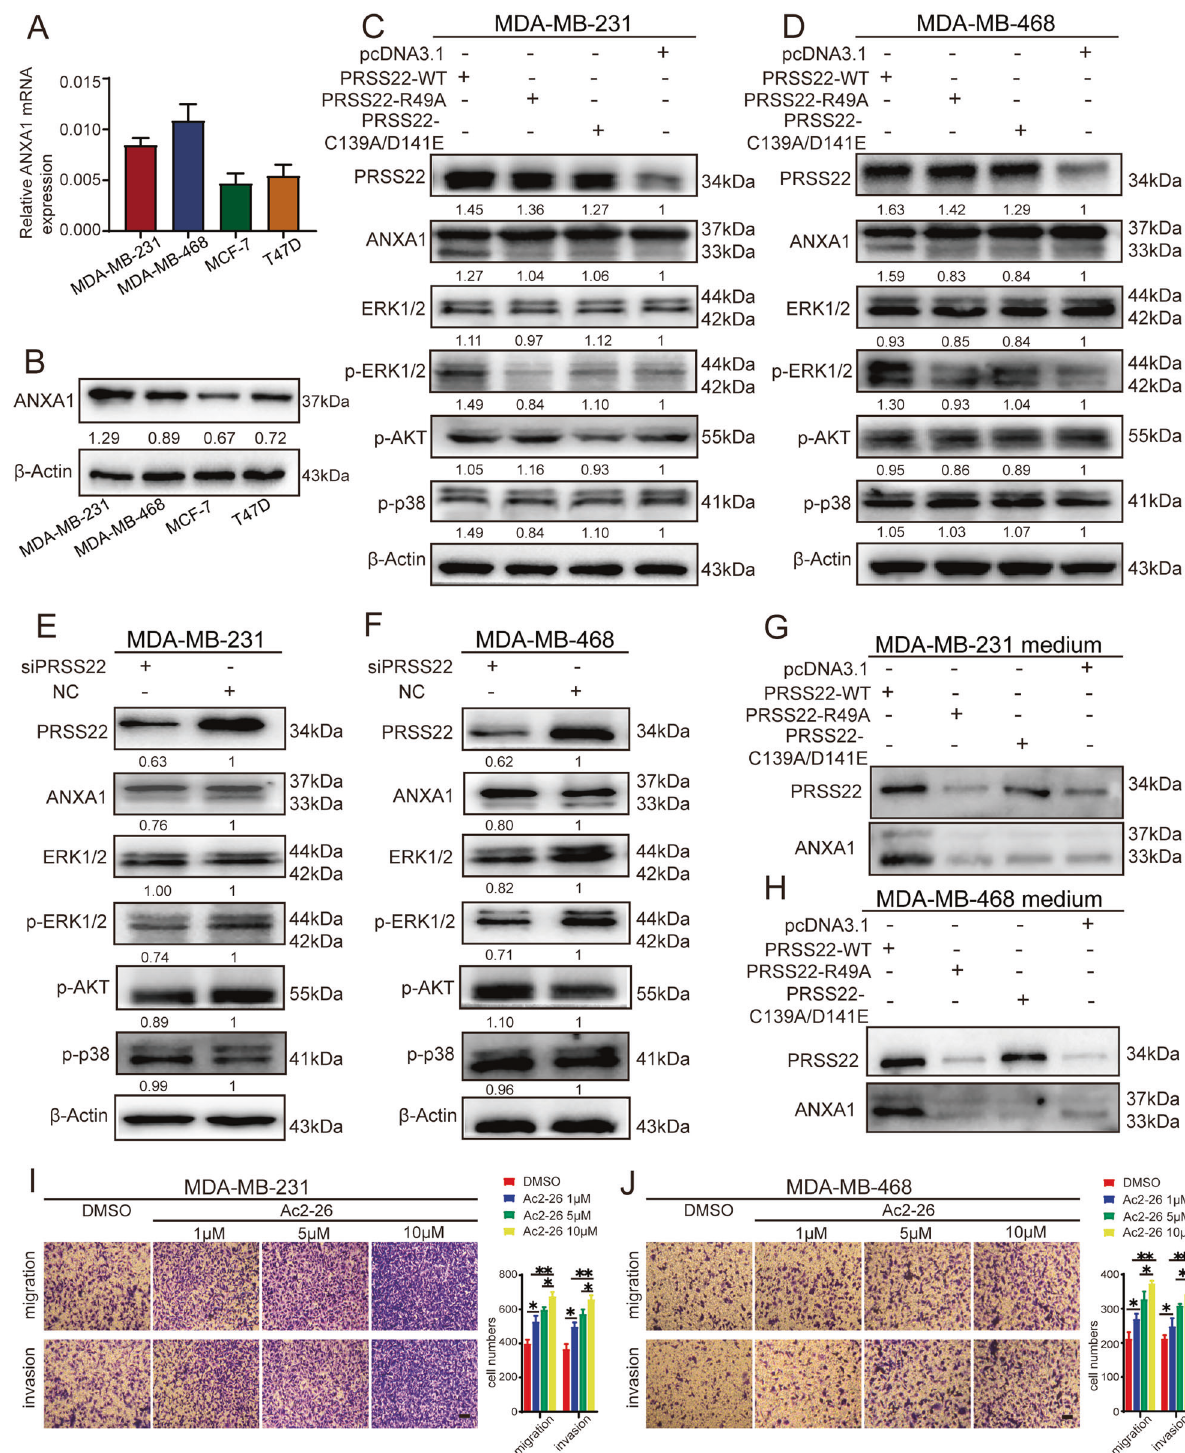
Fig. 5 PRSS22 combined with ANXA1 regulates BC cells migration and invasion by ERK 1/2 signaling pathway. A , B The expression of ANXA1 in triple-negative metastatic cell lines (MDA-MB-231, MDA-MB-468 and MDA-MB-453) and luminal cell lines (T47D and MCF-7) were performed by RT-qPCR ( A ) and Western blot ( B ). C , D Western blot analysis of the different signaling modules downstream of PRSS22 in BC cells expressing PRSS22-WT, PRSS22-R49A, PRSS22-C139A/D141E or control cells. E , F Western blot analysis of the different signaling modules downstream of PRSS22 in BC cells with or without PRSS22 knockdown. G , H The expression of PRSS22 and ANXA1 in concentrated conditioned medium of BC cells expressing PRSS22-WT, PRSS22-R49A, PRSS22-C139A/D141E or control were performed by Western blot. I , J Transwell assays con fi rmed that Ac2-26 induced a dose-dependent increase in migration and invasion (Scale bars, 100 μ m). Data are shown as mean ± SD of three independent experiments, * P < 0.05, ** P < 0.01.